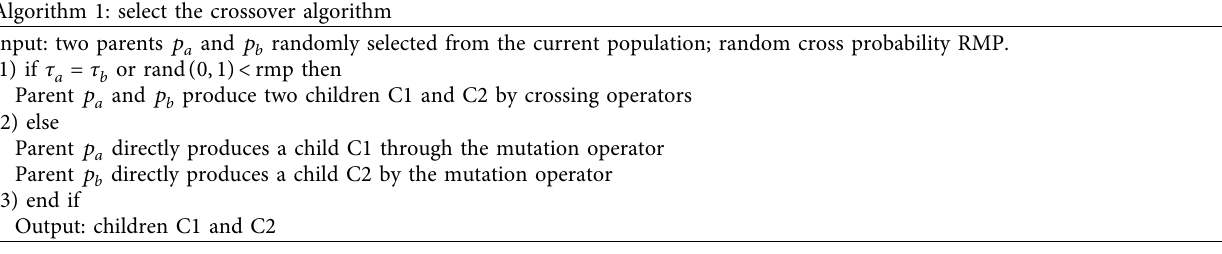
Table 1: Selecting the cross algorithm pseudocodes. Algorithm 1: select the crossover algorithm